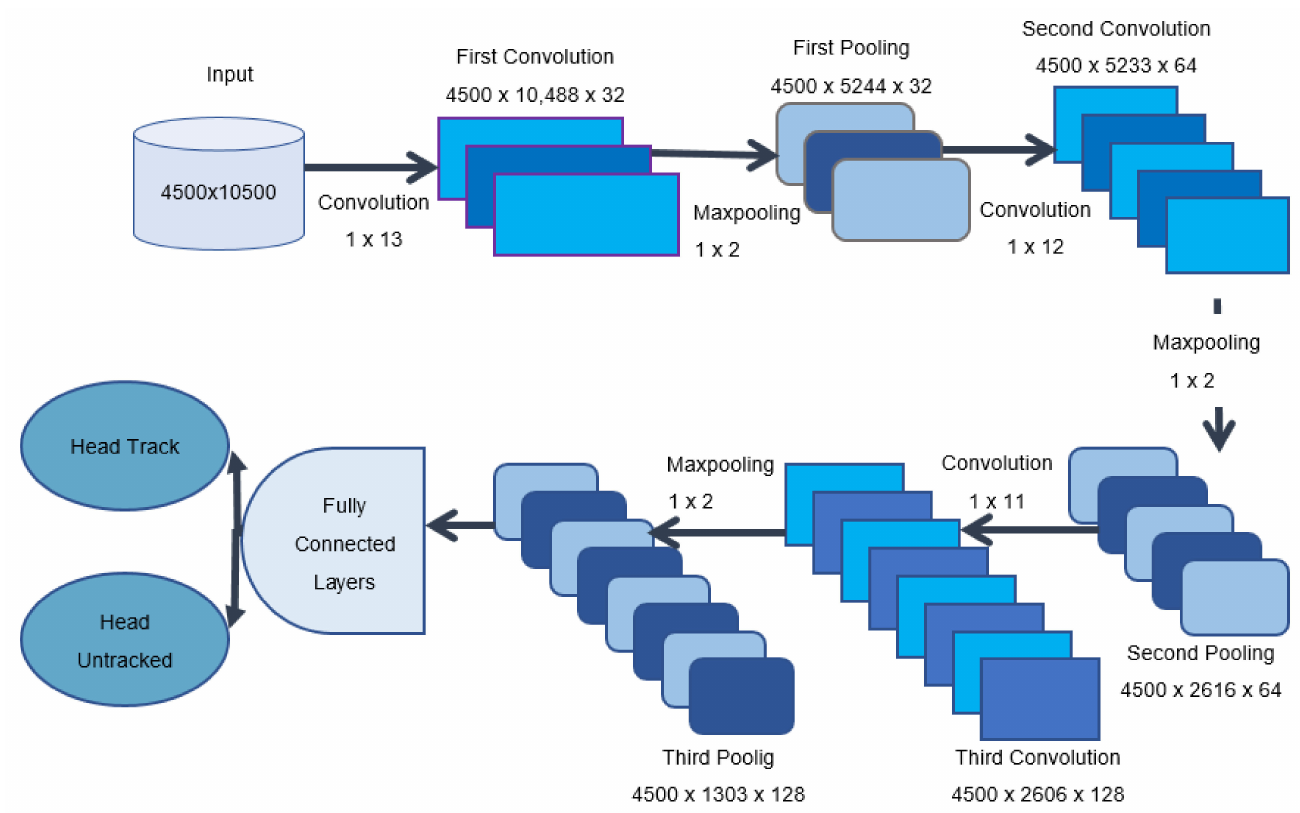
Figure 9. Illustration of the overall architecture of our proposed 1D CNN over PCDS